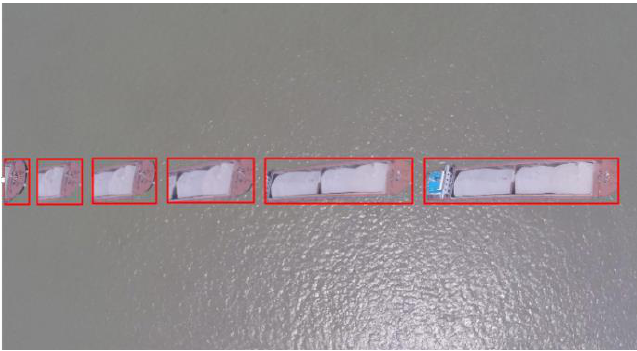
Figure 11. Consecutively detected vessels in a real-time video.